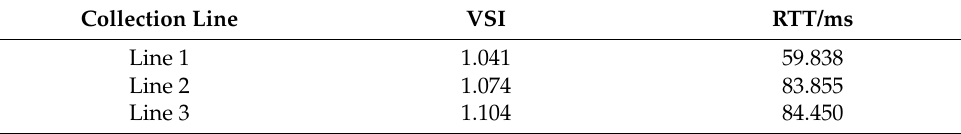
Table 4. HVRT indicators, considering the grid-connection node as the control target.